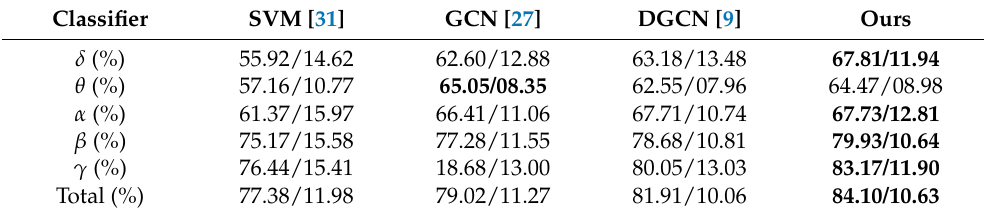
Table 3. The accuracy and standard deviation on SEED with DACU features. The best results are marked in